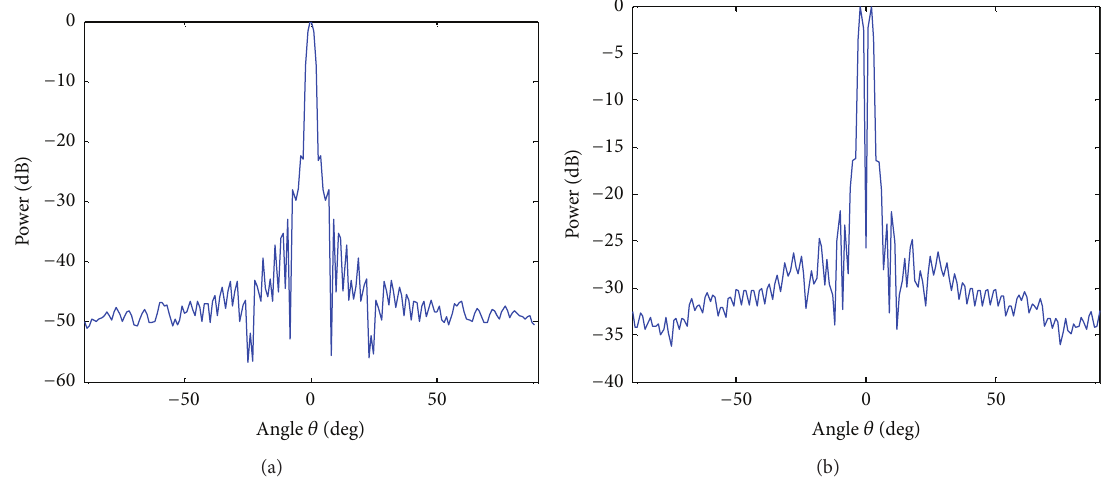
Figure 11: (a) The sum pattern and (b) difference pattern of simulated cassegrain antenna by FEKO at 9 GHz (normalized power).